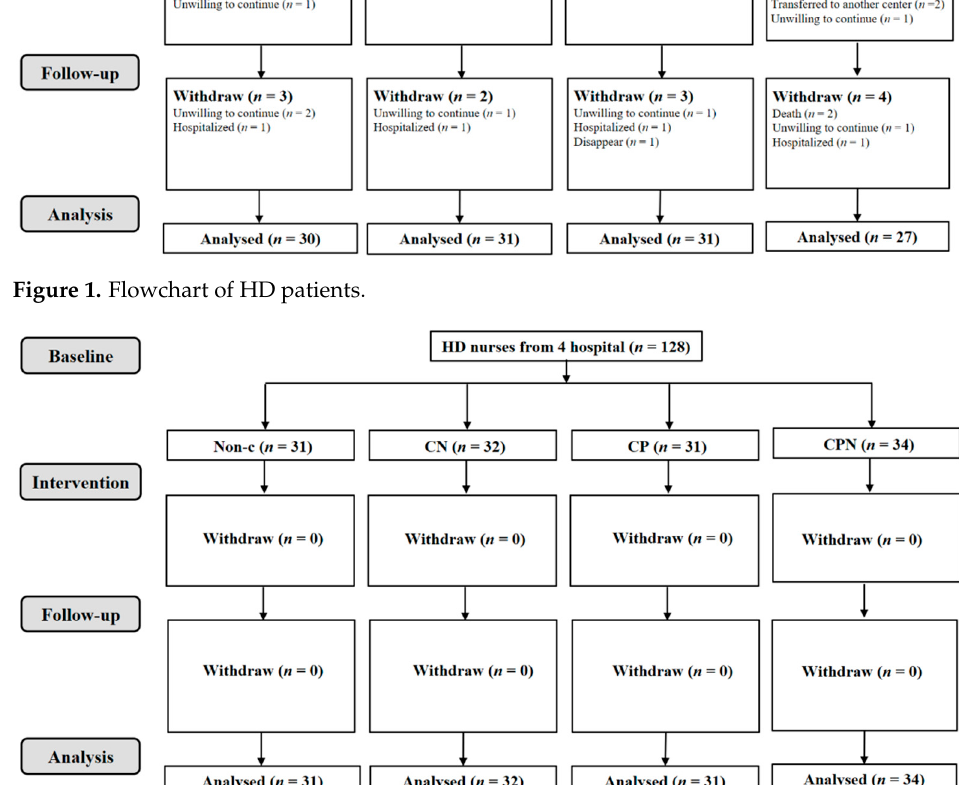
Figure 2. Flowchart of nurses working at the HD departments. Table 1. Characteristics of all subjects at T0.